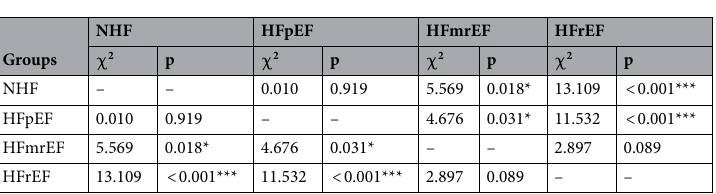
Table 3. Breslow pairwise comparisons of survival distributions by HF groups (n = 1034). HF heart failure, EF ejection fraction, NHF no HF, HFpEF HF with preserved EF, HFmrEF HF with mid-range EF, HFrEF HF with reduced EF. *; **; ***Statistically significant differences (p < 0.05; p < 0.01; p < 0.001).